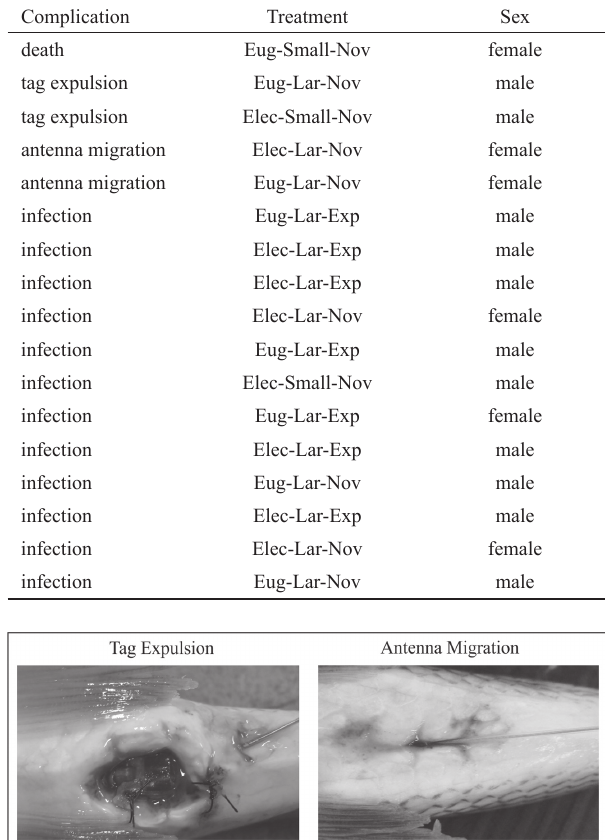
Table 2. Postsurgical complications of Prochilodus lineatus .